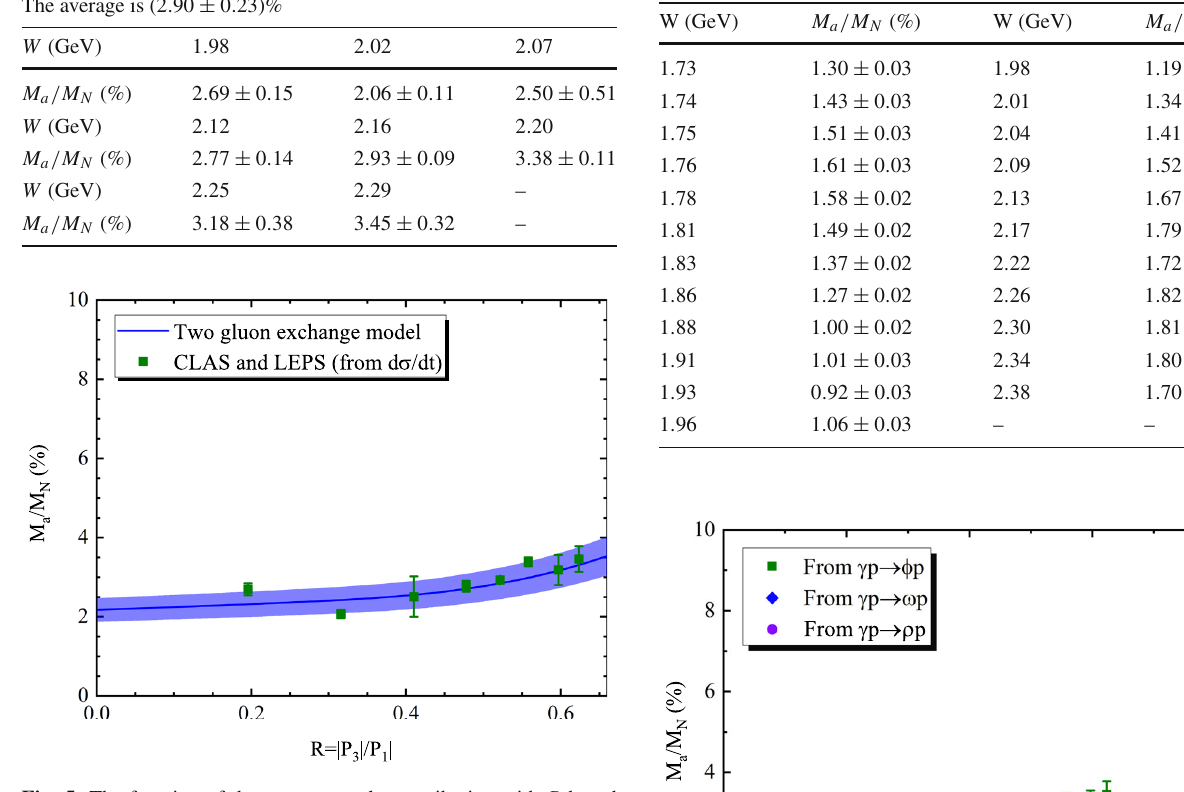
Fig. 5 The function of the trace anomaly contribution with R based on the differential cross section d σ/ dt | t = t gluon exchange model. The notation and the blue band is the same as in Fig. 2